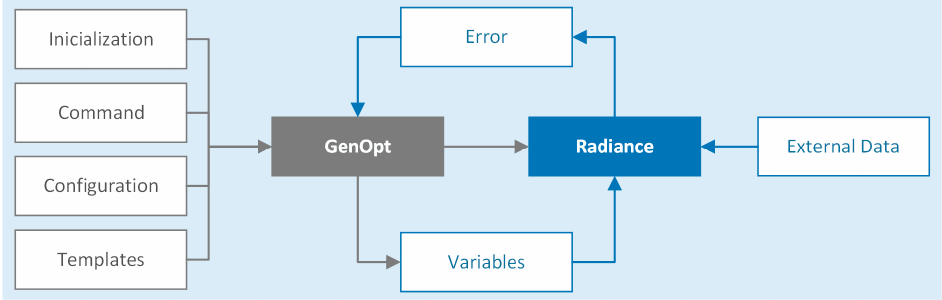
Figure 1. Calibration process combining GenOpt and Radiance for street lighting simulations.